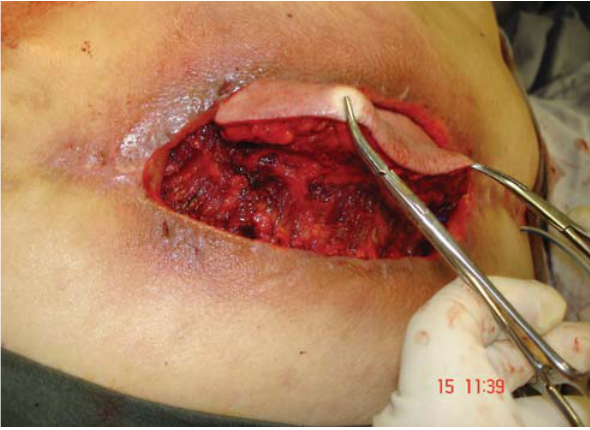
Figure 3 - The latissimus dorsi was rotated and tunelized to reach the midline of the back wound. The muscle was used to fill the defect, while the skin was used to close the wound primarily